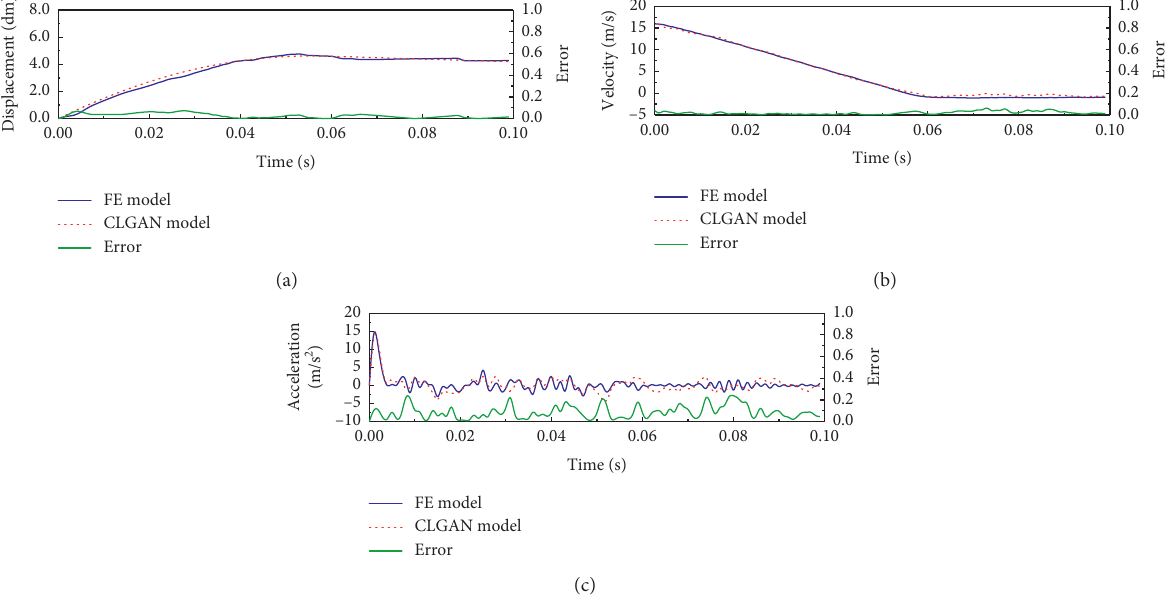
Figure 14: Comparison of the anticlimbing device’s crash dynamic characteristics. (a) Displacement comparison of CLGAN model and FE model. (b) Velocity comparison of CLGAN model and FE model. (c) Acceleration comparison of CLGAN model and FE